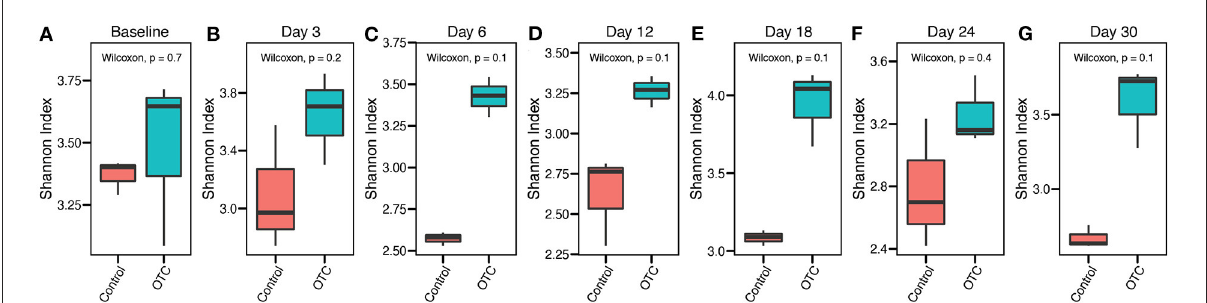
FIGURE2 Trends in the α -diversity of the zebrafish gut microbiome during OTC exposure. (A–G) α -diversity (Shannon Index) comparisons between the control and OTC exposure groups at different timepoints during the one-month exposure window are shown. These results indicated the differences in the α -diversity were not statistically significant (Wilcoxon test, P > 0.05) between the two groups at all of the sampled timepoints. However, the mean α -diversity remained relatively higher in the OTC exposure